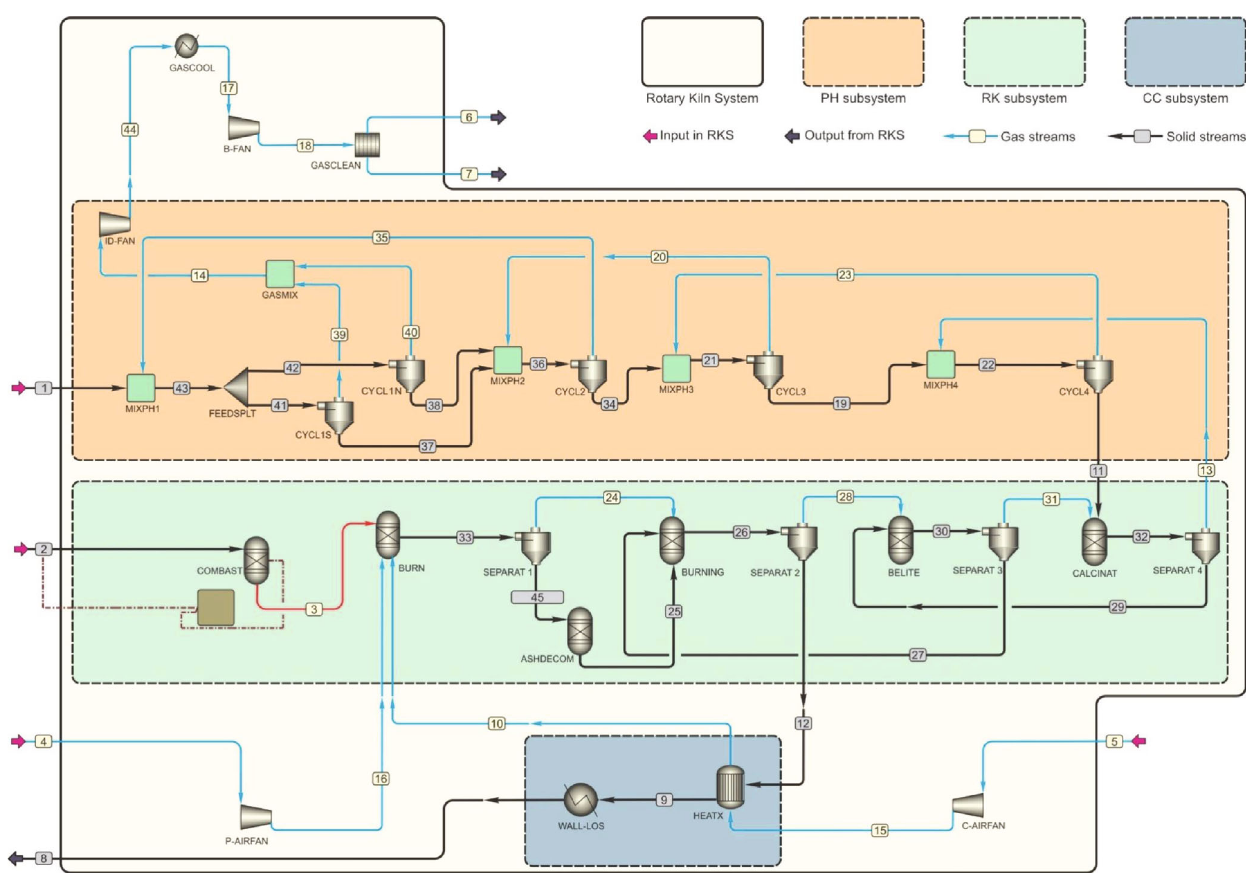
Figure 3: Flowsheet of RKS created by Aspen Plus